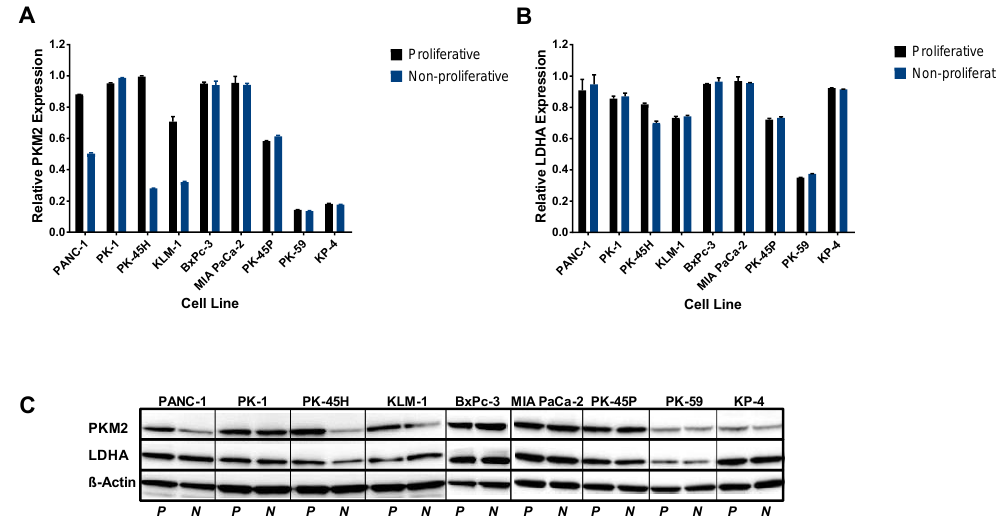
Figure 1. Pyruvate kinase M2 (PKM2) and lactate dehydrogenase A (LDHA) expression in human pancreatic cancer cell lines. ( A ) Relative PKM2 expression and ( B ) Relative LDHA expression in proliferative and nonproliferative phases of cell culture in nine pancreatic cancer cell lines. ( C ) Western blots showing expression levels compared with loading controls across the cell lines. Data presented as relative expression ± SE, obtained from chemiluminescence intensity of PKM2 and LDHA normalized to chemiluminescence intensity of β -actin.